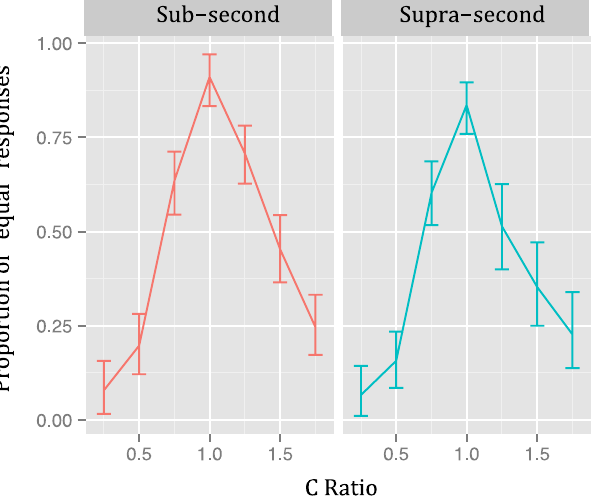
Figure 4. Temporal generalization gradients of Experiment 2 (linearly spaced ratios). Proportion of “equal” responses as a function of the ratio of the comparison duration when collapsing presentation orders Vertical lines represent 95% confidence